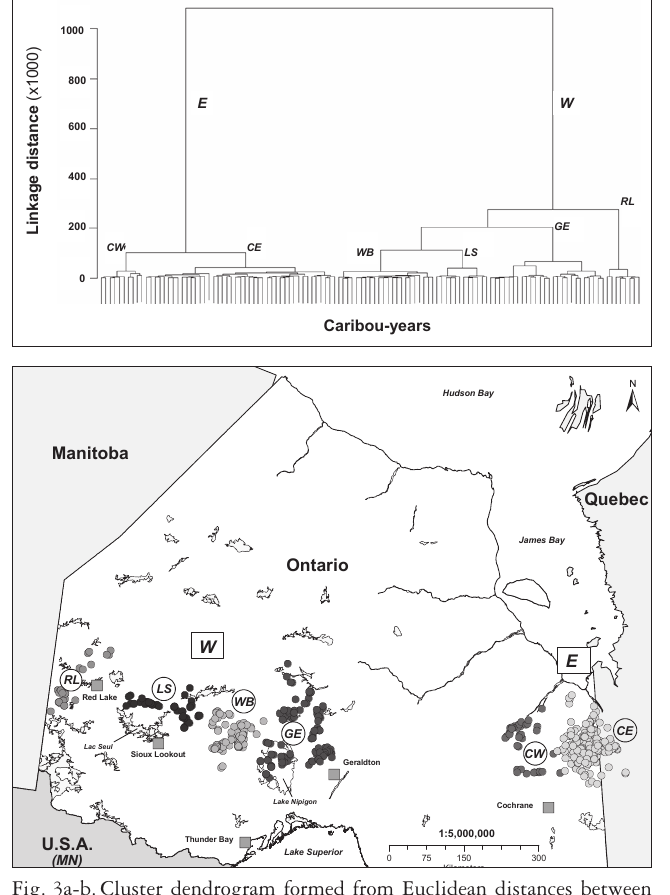
Fig. 3a-b. Cluster dendrogram formed from Euclidean distances between means of last clusters joined using the sum of squares (i.e., “Ward’s”) method (a) and geographic extent of corresponding clusters (b), depicted using the seasonal median locations of classified woodland caribou ( n =73). Each terminal point in (a) represents one object (i.e, caribou-year), which include 1 full year of location data for a single individual. In both figures, the western and eastern sampling regions are labeled “W” and “E”, respectively. The six clusters delineated were: Red Lake = “RL”, Lac Seul = “LS”, Wabakimi = “WB”, Geraldton = “GE”, Cochrane West = “CW”, Cochrane East =